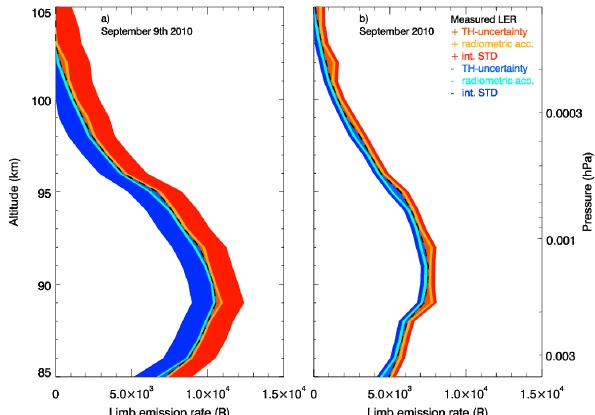
Figure 4. Sample daily (a) and monthly (b) averaged green line LER profiles for the 20–25 ◦ N latitude range with uncertainty com- ponents σ + (orange), σ + a (yellow) introduced for determining P + 1 h and calculated for LER + 1 and σ l (red) calculated directly for LER + 1 . Similarly, σ − (light blue) and σ − a (cyan) are introduced h when calculating P − 1 and are propagated to determine LER − 1 . σ l (blue) is directly calculated for LER − 1 . See Sects. 3 and 6.1 for further